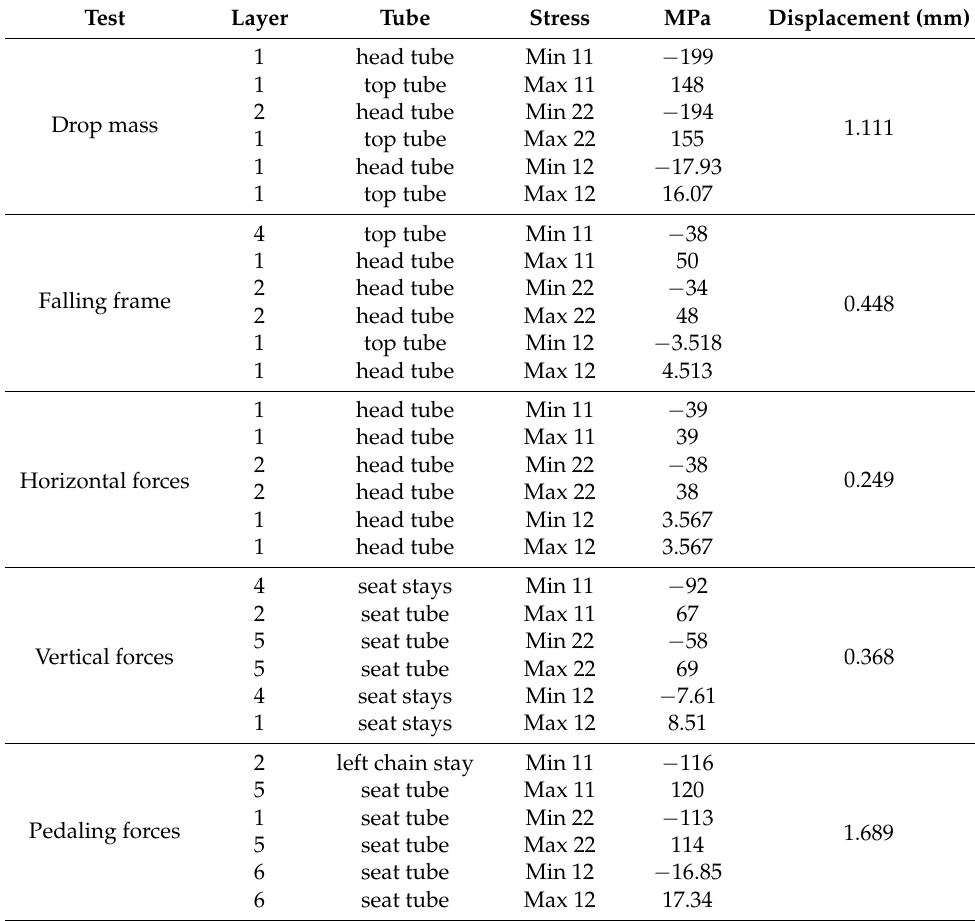
Table 19. Stress and displacement results of stacking scenario 1.